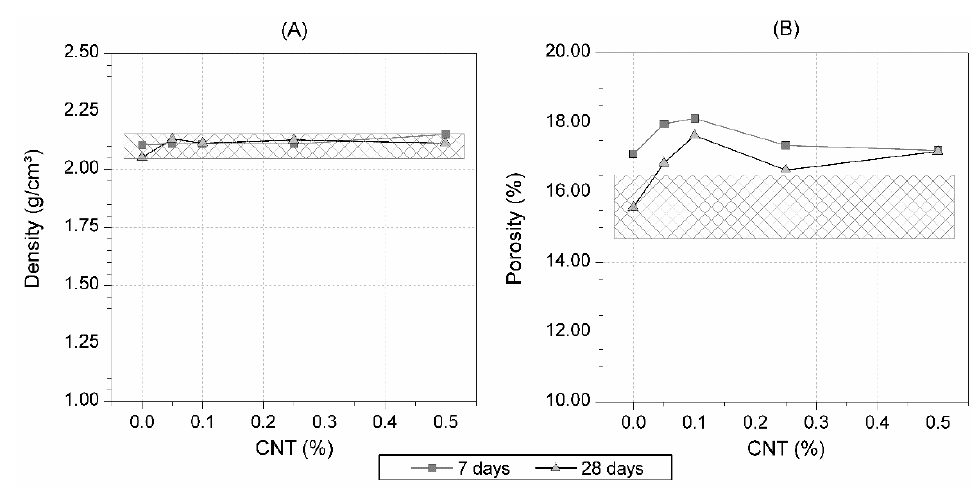
Figure 2. ( A ) Apparent density and ( B ) porosity of mortars with different amount of CNT tested at 7 and 28 days curing time. The hash-marked area represents the confidence interval for the average value of the 28-days reference mortar without CNT, with a confidence level of 95%, according to UNE 66040:2003